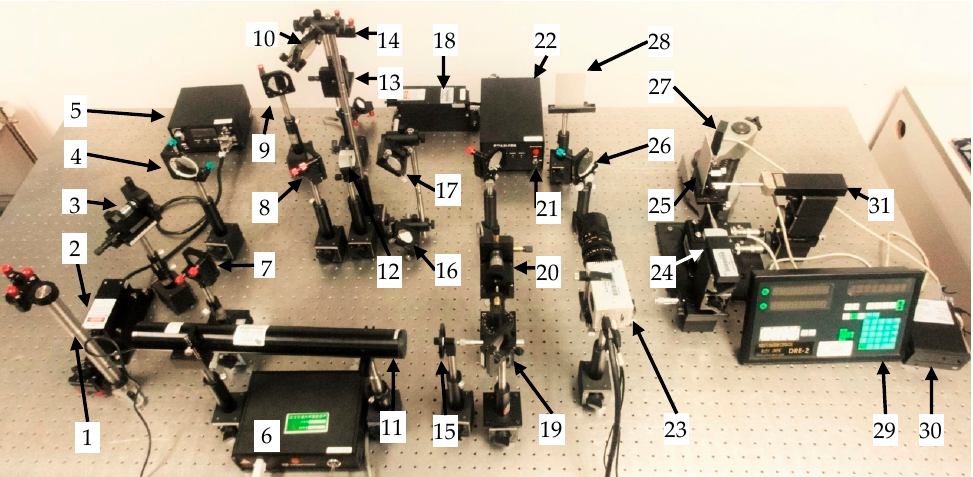
Figure 7. Experiment setup: 1 and 14 are beam lifters; 2, 11, and 18 are the blue, red, and green laser;